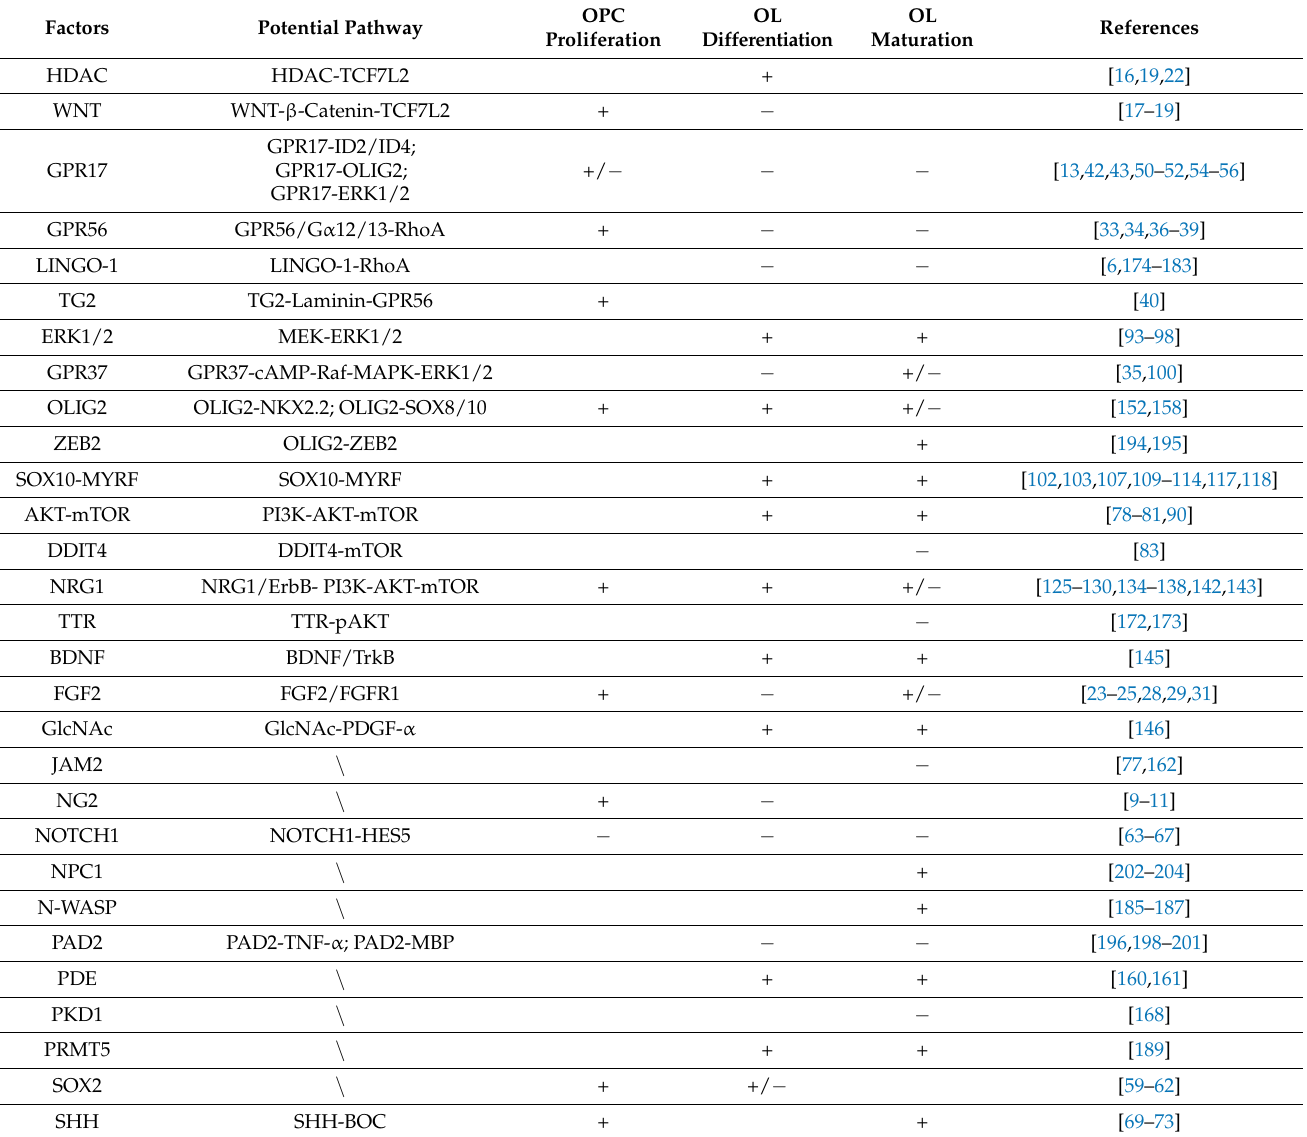
Table 1. Functions of the factors in the specific stages of OL